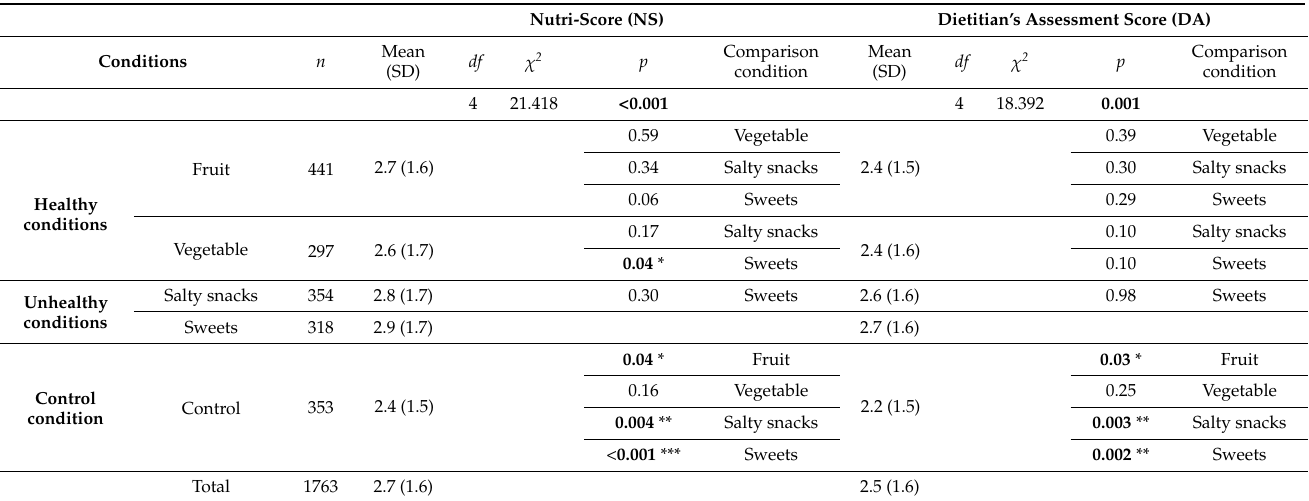
Table 2. Nutri-Score and Dietitian’s Assessment Score per